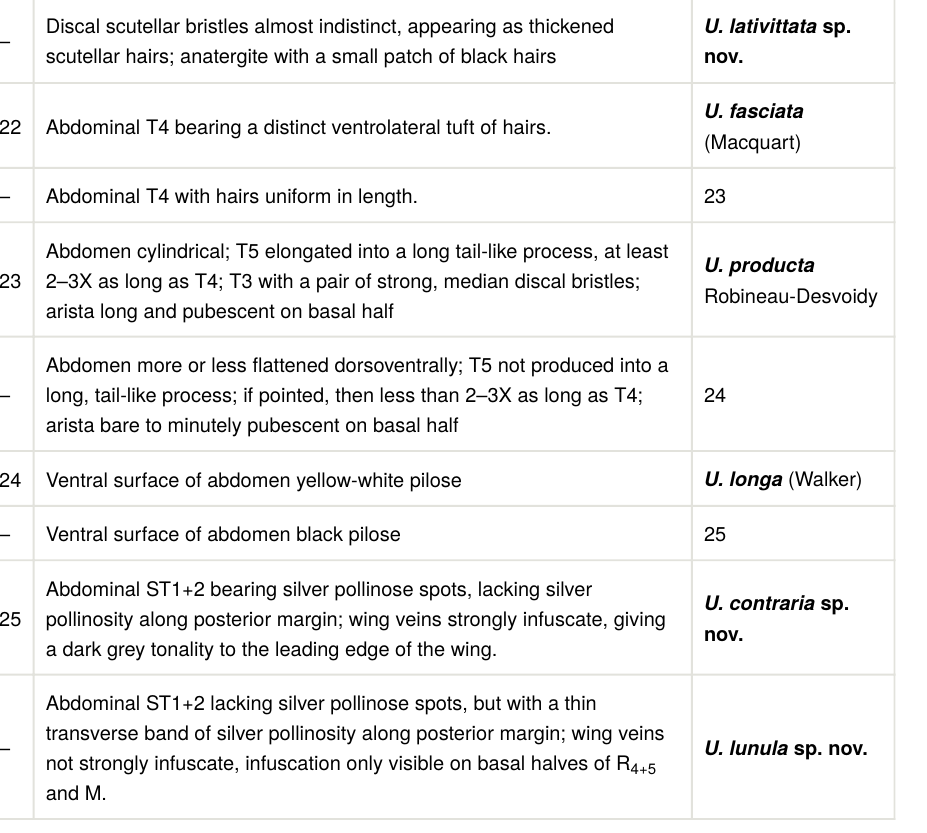
Fig. 19 is a Neighbor Joining tree (NJ) (Saitou and Nei 1987) for the Uramya holotypes reared and DNA-barcoded by this inventory to date. The DNA barcode sequences obtained from the ten species of ACG Uramya displayed the strong AT bias characteristic of insect mitochondrial DNA (mean percent GC content 30.33%, SE 0.1) and displayed no insertions or deletions. Within-species variation was low compared to between-species variation. All values of DNA barcode variation were calculated within BOLD and can be re-calculated in the future as more specimens or species are added to the DNA library.